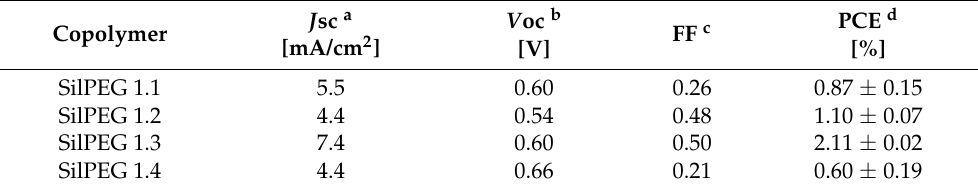
Figure 6. J-V characteristics of SilPEG:PC61BM blends. Table 6. PL1. Photovoltaic parameters of the BHJ solar cells.